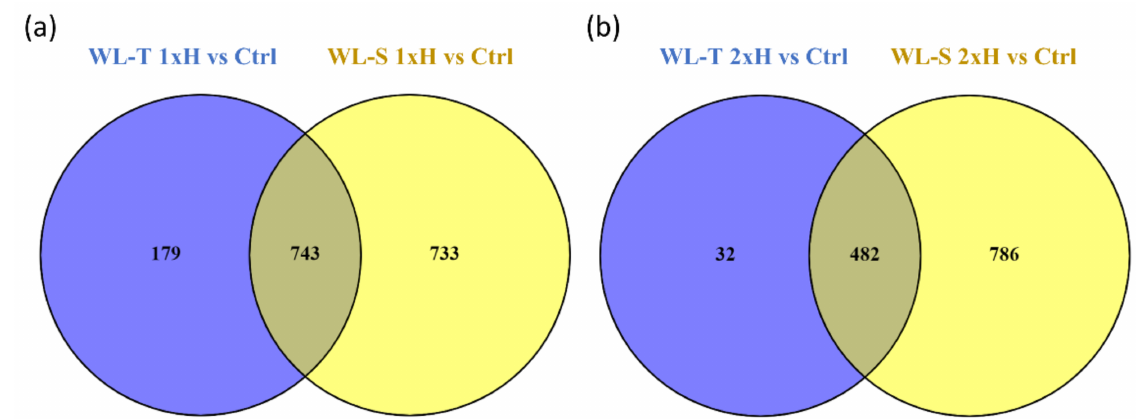
Figure 3. Venn diagrams showing the number of differentially expressed lncRNAs that are commonly and uniquely regulated in: ( a ) non-primed (1xH) and ( b ) primed (2xH) plants in two cucumber accessions, WL-T and